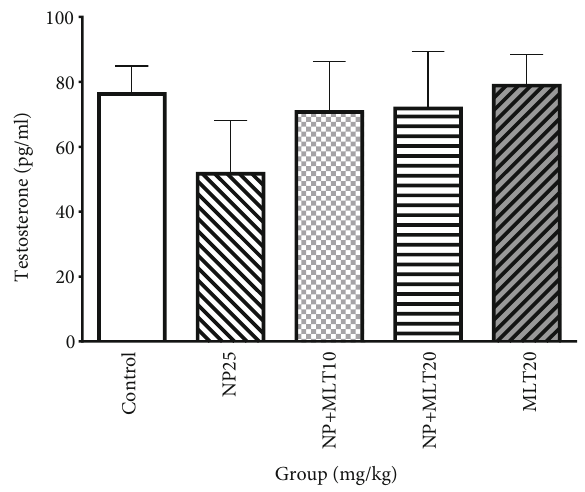
Figure 3: Melatonin and nonylphenol did not change testosterone concentration. Comparison the level of testosterone in all experimental groups. Bars represent mean ± SD ( n = 4